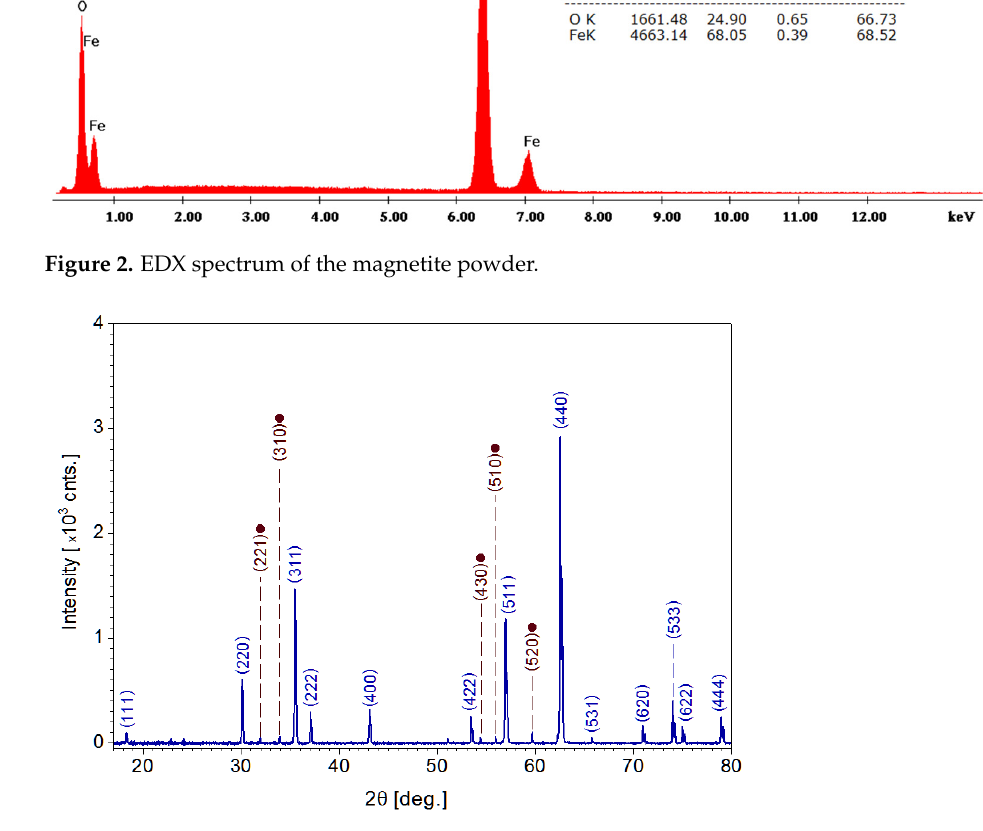
Figure 2. EDX spectrum of the magnetite powder.